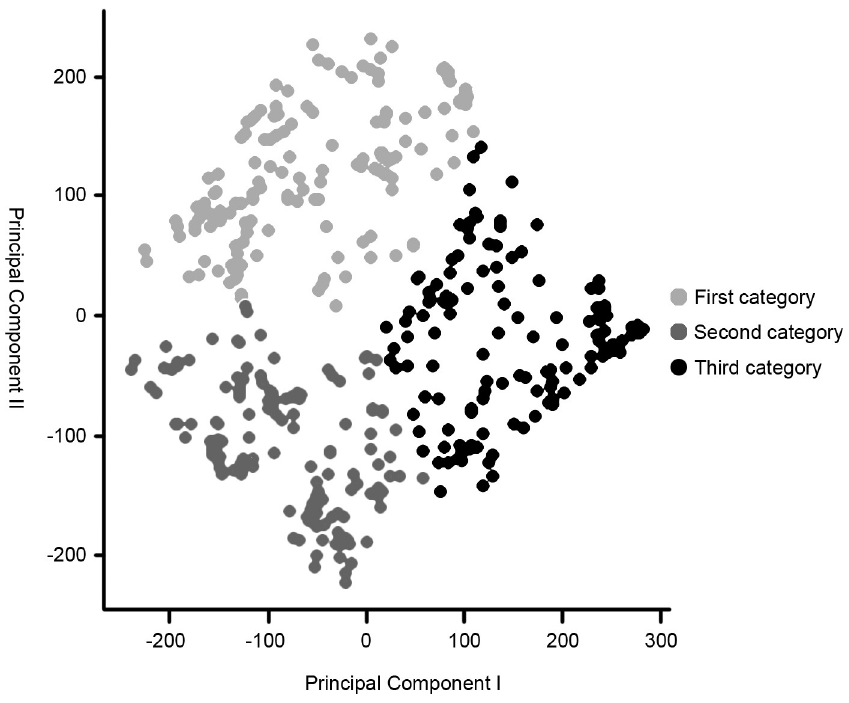
Fig 4. Clustering analysis scatters